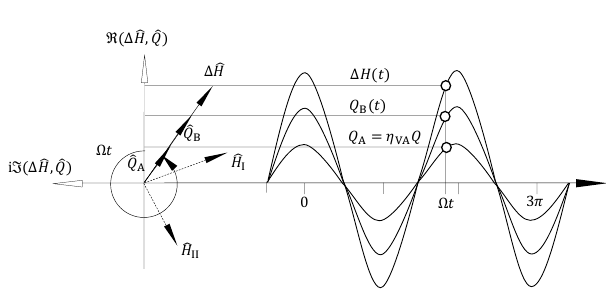
Fig. 3. Electrical analogy to a quasi-steady tidal channel flow for ε ≪ 1 , Wo ≪ 1 .